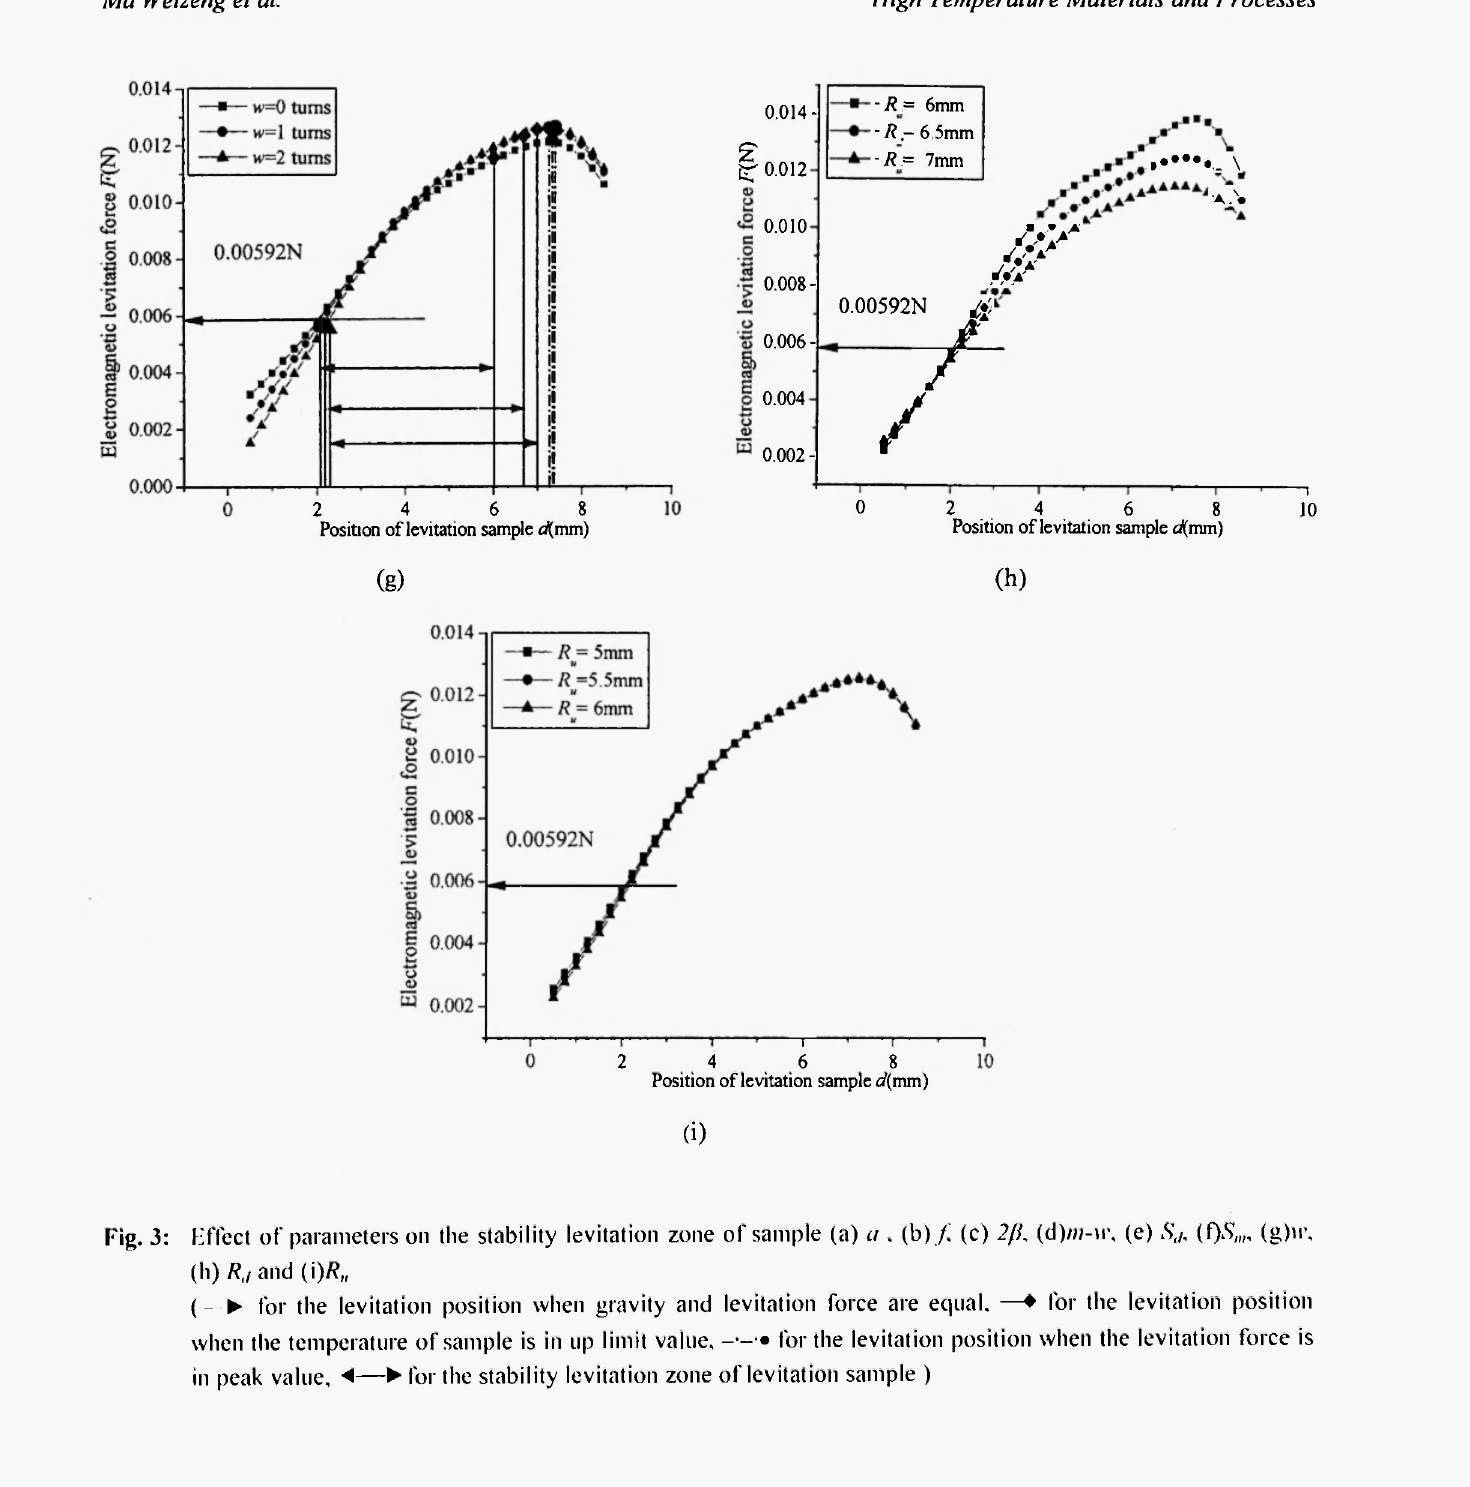
Effect of parameters on the stability levitation zone of sample (a) a . (b) f. (c) 2/1. (d)w-ir. (e) S,,, (f ~)S„„